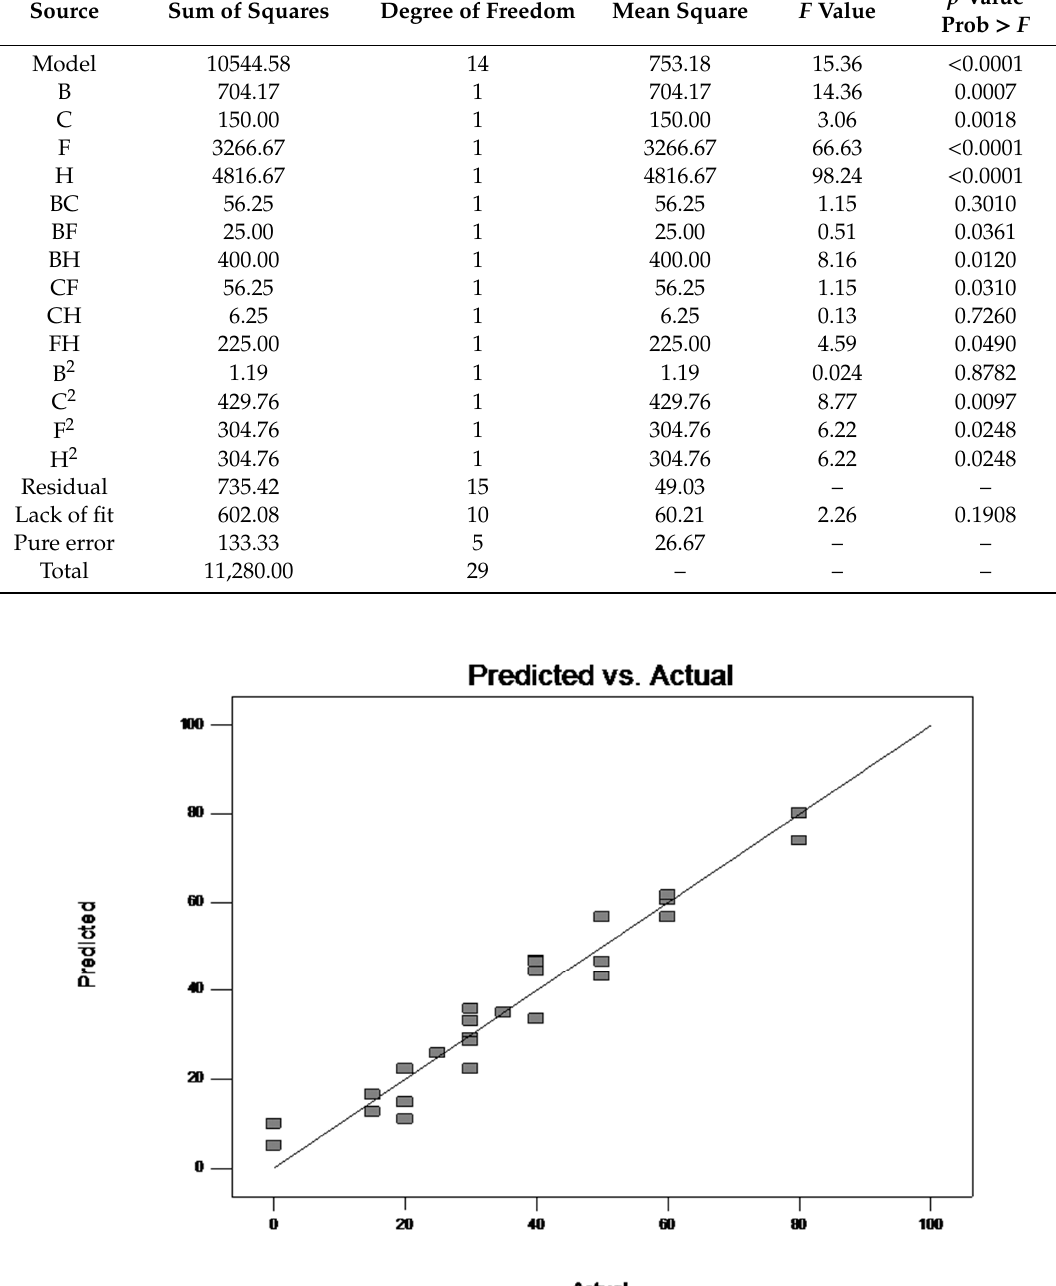
8 of 16 Table 5. Analysis of variance for the response surface of the quadratic polynomial model. Source